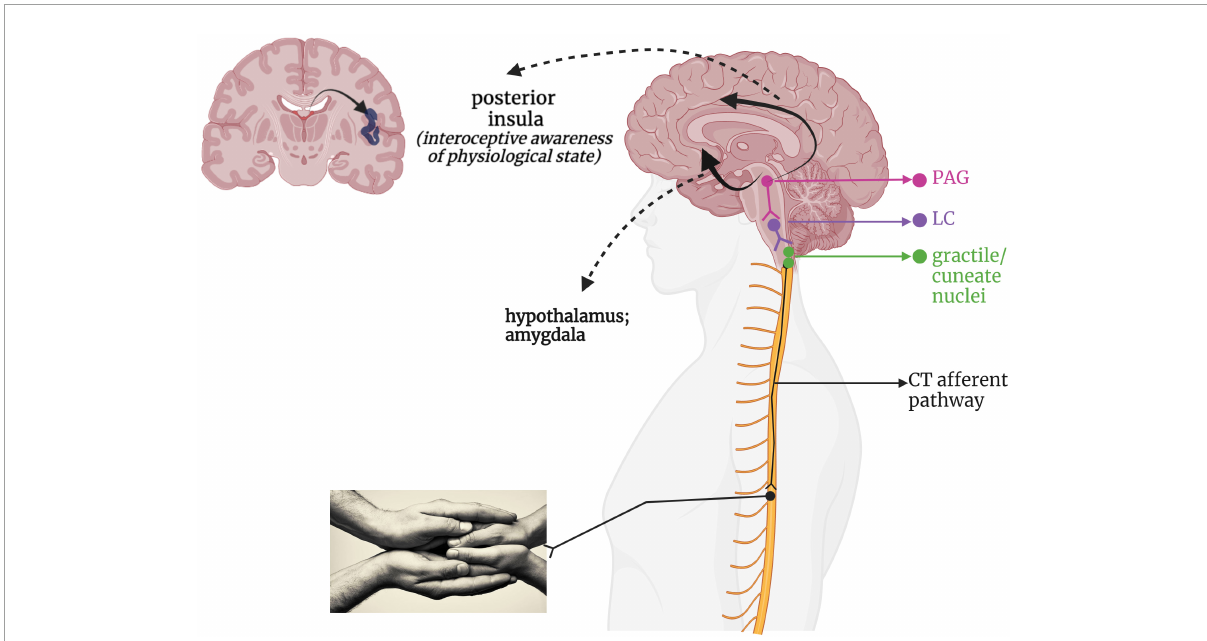
FIGURE4 A putative CT-afferent pathway. Light stroking touch to the skin first arrives at the gracile and cuneate nuclei within the brainstem, which interacts with the LC within the RAS to influence arousal. This information flows onward to the midbrain PAG for determination of affective valence and survival relevance. This integrated information then is relayed via a ventral stream to the amygdala and hypothalamus for further emotional processing and endocrine responses, as well as a dorsal stream providing indirect connections to the cingulate cortex and posterior insula. LC, locus coeruleus; PAG, periaqueductal gray; PI, posterior insula; RAS, reticular activating